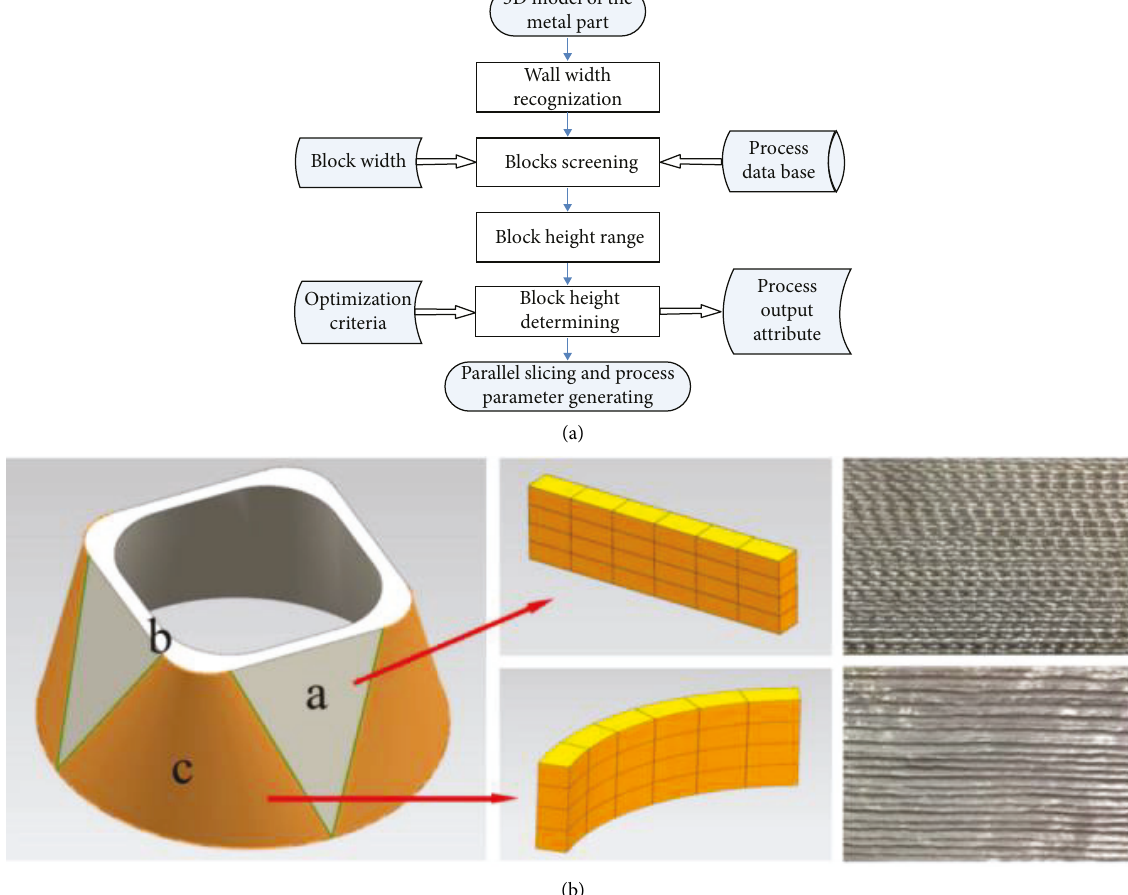
Figure 25: (a) Workflow for decomposing unit blocks in single layer. (b) A typical model with different dimensional attributes and surface